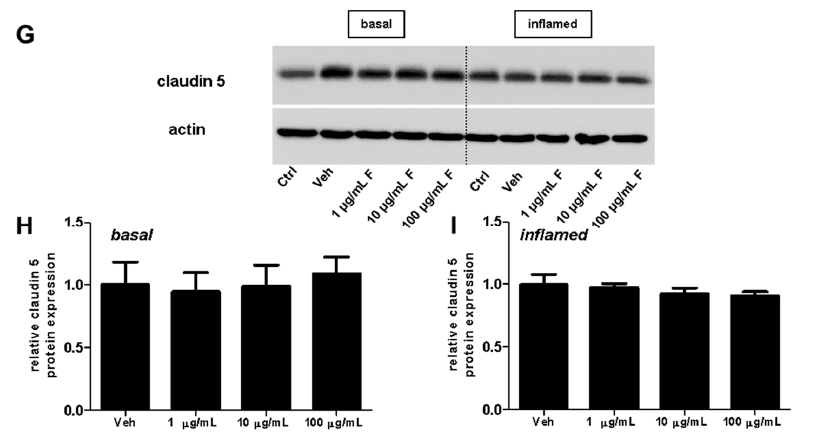
Figure 5. Effect of fullerenols on the amount of junctional proteins in mouse brain microvascular endothelial cell (MBMEC) cultures under basal and inflammatory conditions. Western blot analysis and densitometric quantification (normalized to basal or inflamed untreated control cell cultures) of the amount of occludin ( A – C ), claudin 3 ( D – F ) and claudin 5 ( G – I ) proteins in MBMEC after exposure to interferon- γ and tumor necrosis factor- α (I + T; 100 IU each) and treatment with fullerenol (F; 1, 10 and 100 µg/mL; n = 4-5) for 18 h ( C , F,I ) compared to cultures under basal (homeostatic milieu) conditions ( B , E,H ). β -Actin was used as loading control. Ctrl, untreated control; Veh, vehicle treatment. * p < 0.05; ** p < 0.01.